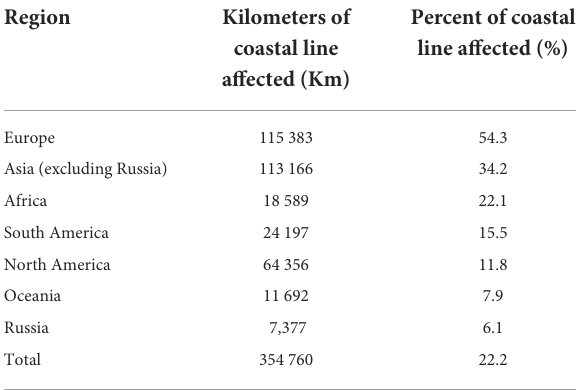
TABLE 2 The extent of coastal line light pollution around the world. Region Kilometers